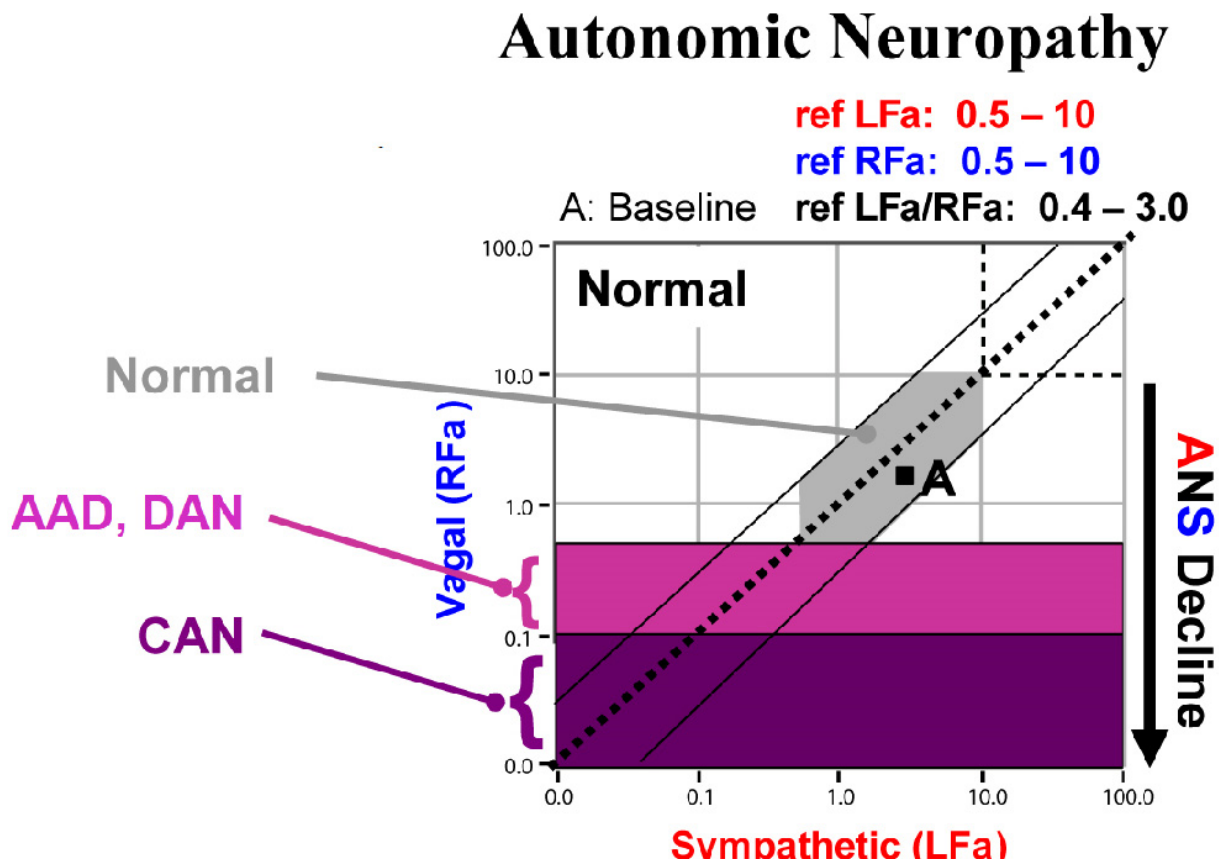
Figure 3. “Normal at Rest” An example resting (baseline) parasympathetic and sympathetic (P&S) response plot. The gray area depicts the normal response region. The purple highlighted areas depict the definitions of advanced autonomic dysfunction (AAD, light purple), diabetic autonomic neuropathy (DAN, also light purple) and cardiovascular autonomic neuropathy (CAN, dark purple). AAD and DAN indicate morbidity risk and CAN indicates mortality risk. Risk is stratified by sympathovagal balance. the space between the two outer diagonal lines defines normal sympathovagal balance (“LFa/RFa”). Regardless of resting autonomic state, normal sympathovagal balance normalizes morbidity and mortality risks. Above and to the left of the upper diagonal line indicates low sympathovagal balance which is a resting parasympathetic excess. Below and to the right of the lower diagonal line indicates high sympathovagal balance which is a resting sympathetic excess.